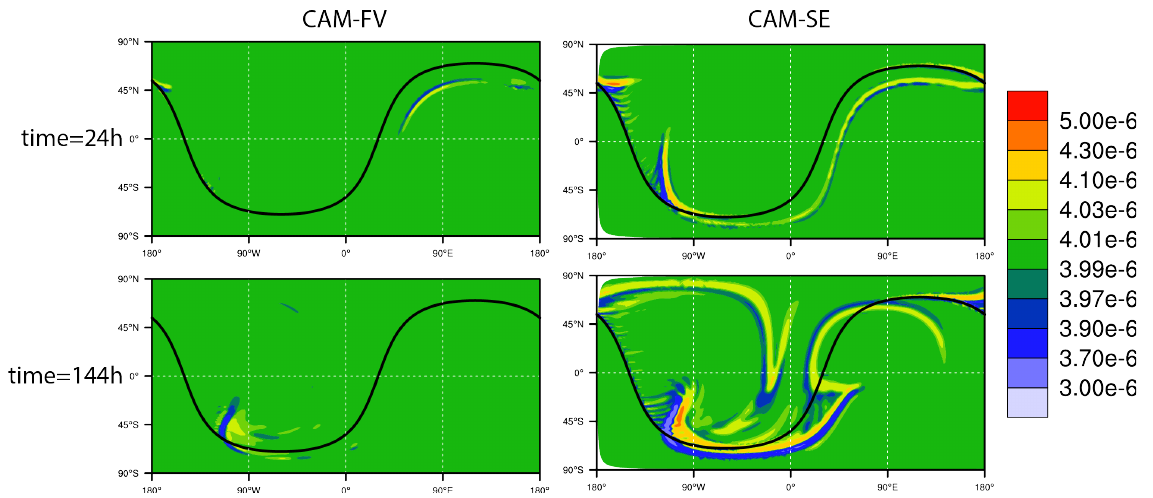
Figure 3. Contour plots of Cl y for (left column) CAM-FV and for (right column) CAM-SE in ftype = 0 configuration at day 1 (upper row) and day 6 (lower row), respectively. Solid black line is the location of the terminator line. Note that the contour levels are not linear.